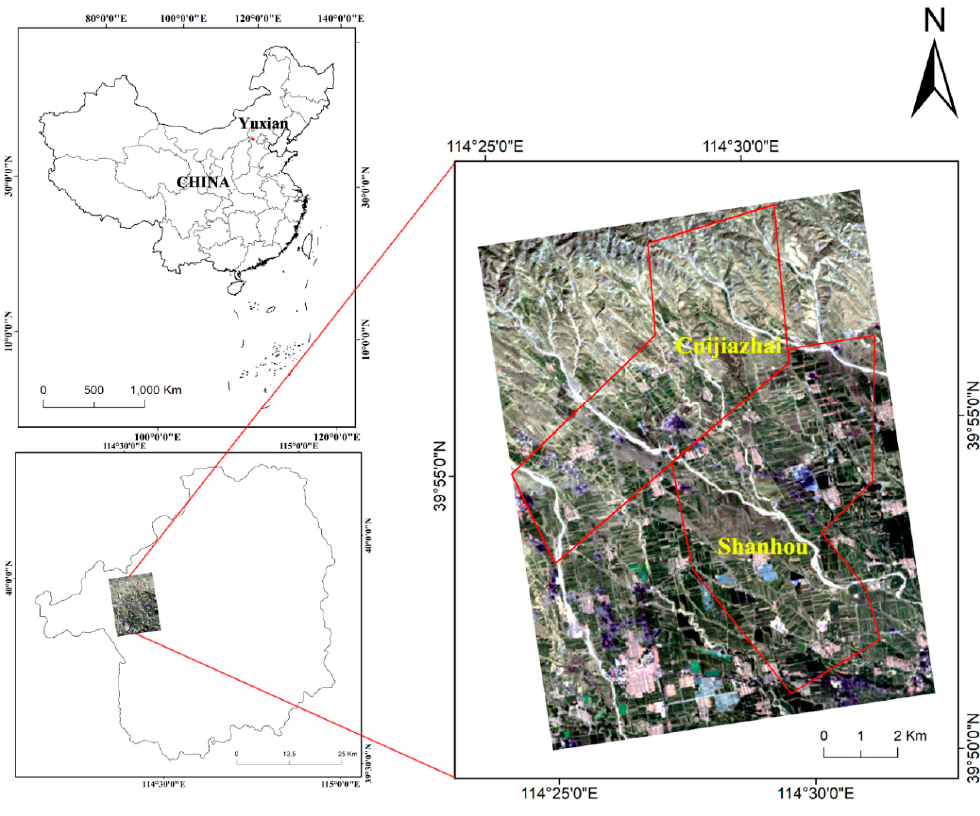
Figure 1. Geographical location of the coalfield and study area. (The remote sensing imagery resource is OLI and the band combination is 4(R) 3(G) 2(B)).